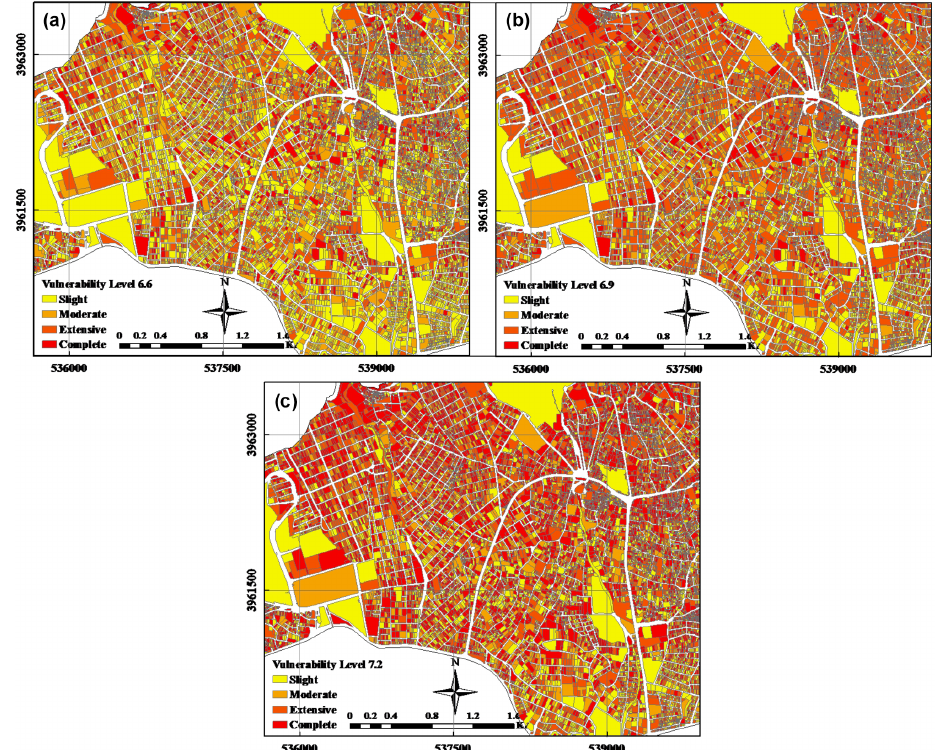
Figure 5. Vulnerability maps for District 1, based on earthquakes with magnitudes of (a) 6.6, (b) 6.9, and (c) 7.2 on the Richter scale.